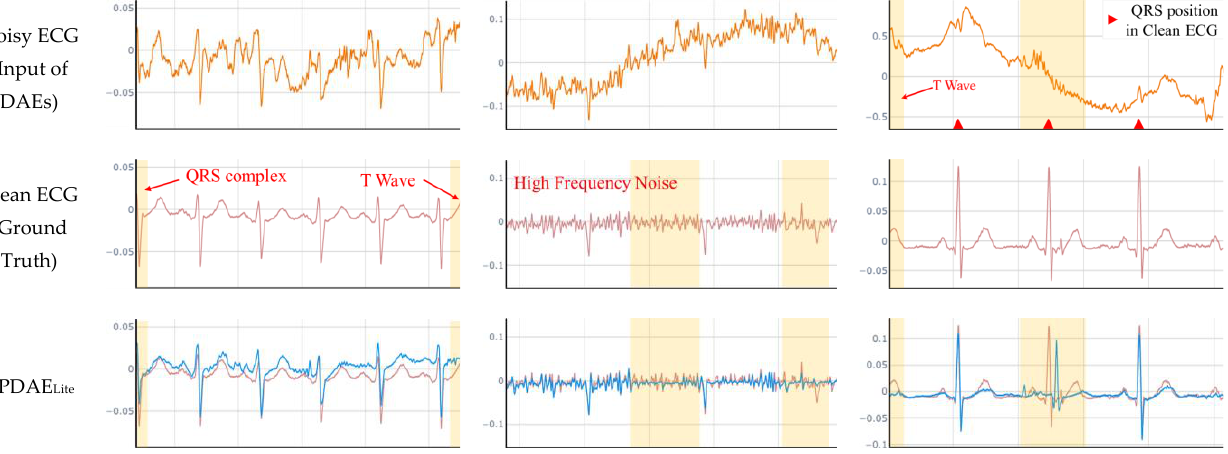
Figure 17. Reconstructed ECGs of various DAEs in self-recorded ECG.